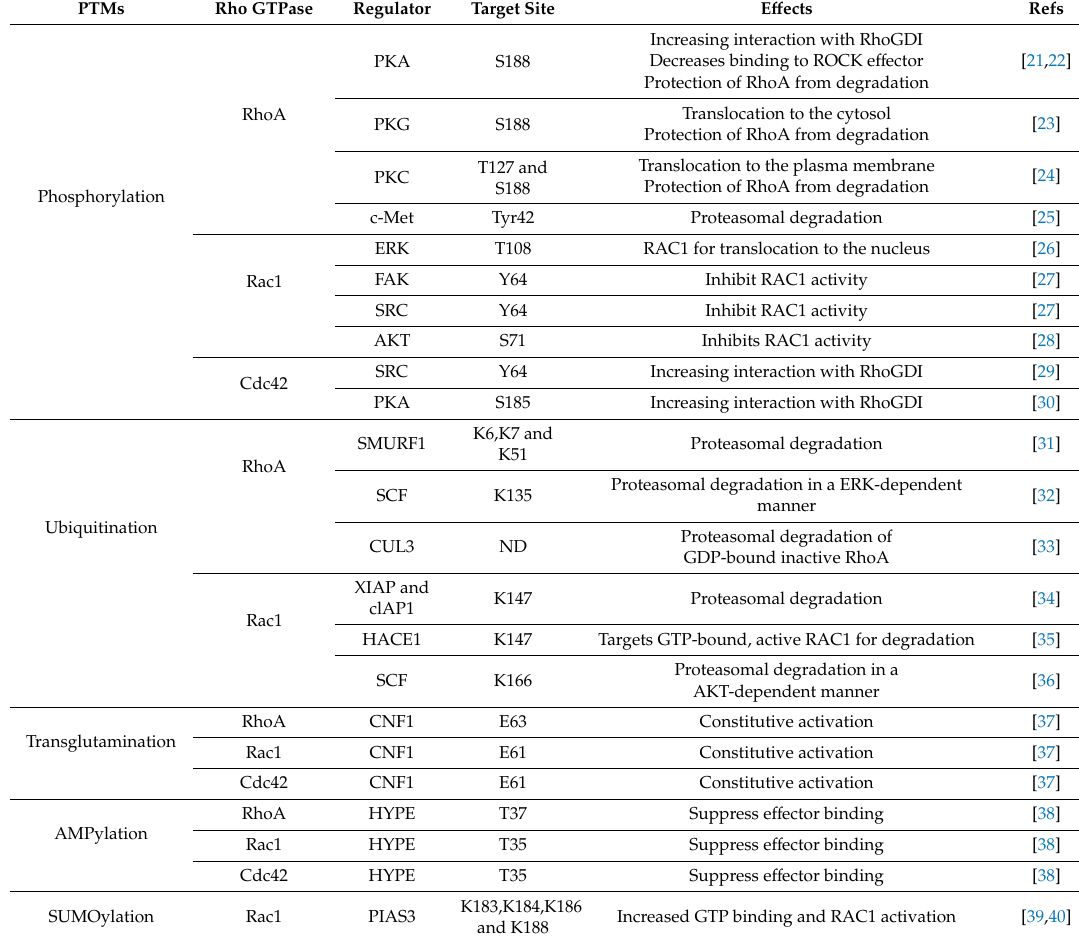
Table 1. Post-translational modifications of Rho